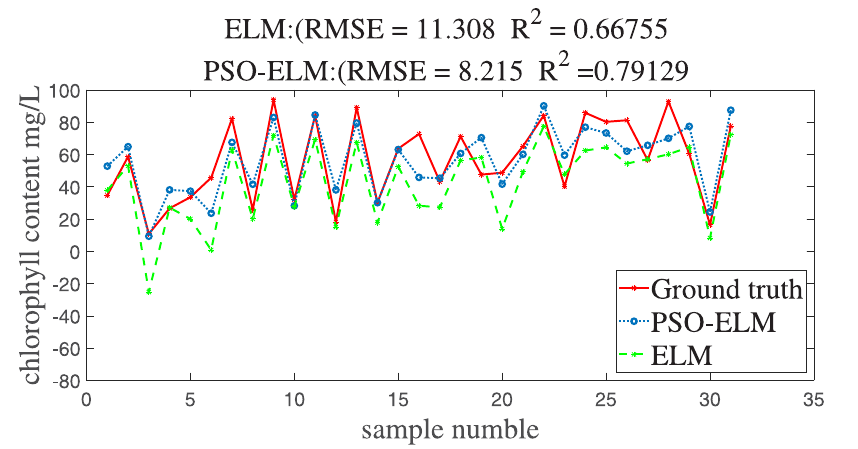
Fig 7. Inversion results of japonica rice canopy chlorophyll